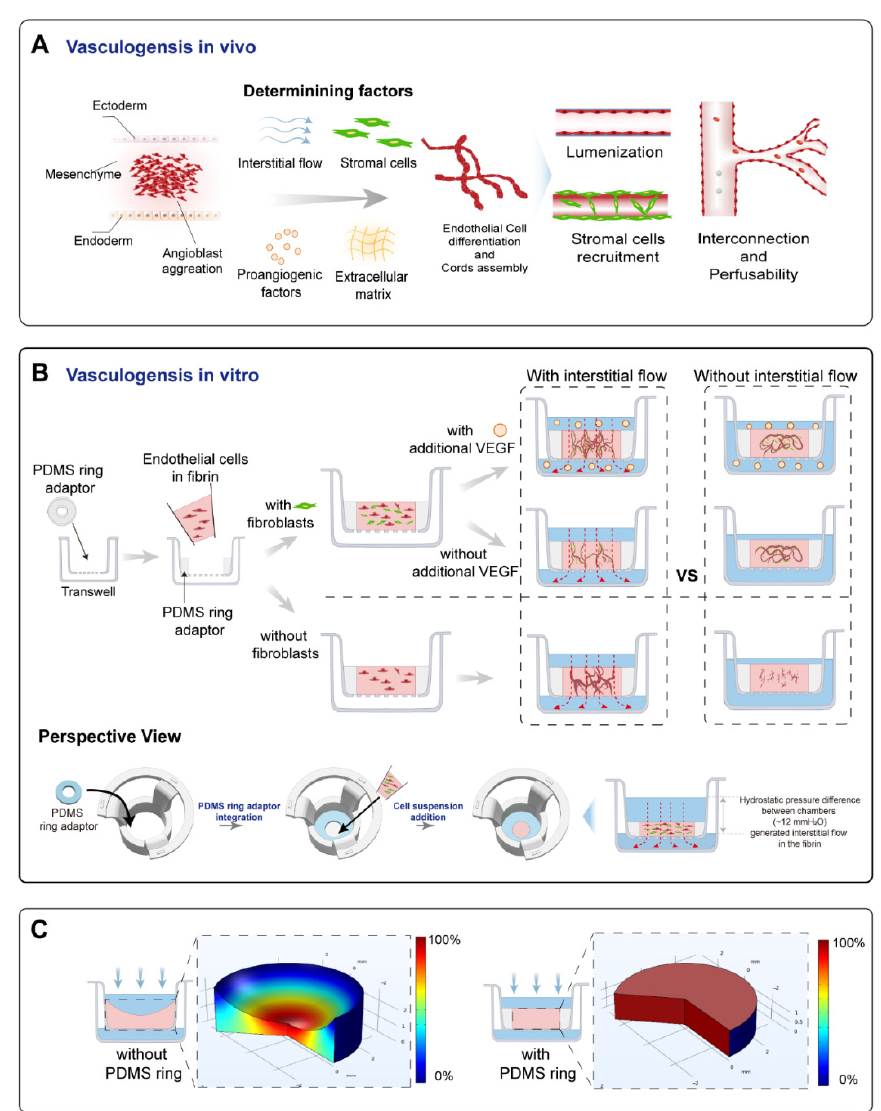
Figure 1. A schematic of the principle and the vascularized model design. ( A ) A schematic of the vasculogenesis in vivo. Vasculogenesis starts from angioblast aggregation and is orchestrated by various factors, including interstitial flow, stromal cells, pro-angiogenic factors, and the extracellular matrix. These determining factors were the focus of this study. Angioblast aggregation gradu- ally develops into assembled cords, then forms lumens, and further becomes interconnected and perfusable. Stromal cells are recruited to form the basement membrane and stabilize the vessels. ( B ) The operational process of this study. A PDMS ring adaptor was glued onto the membrane of the transwell using uncured PDMS. The endothelial cell suspension in fibrin mixed with/without fibroblasts was added into the central cavity of the PDMS ring. After fibrin solidification, a specific amount of medium with/without additional VEGF was added to the apical and basolateral chamber to achieve controllable hydrostatic pressure difference between chambers to apply an interstitial flow into the tissue. During 7 days of culture, interconnected vascular networks were formed. Addition- ally, comparisons between the fluidic and static groups were analyzed. ( C ) The simulated relative flow velocity distribution in the acellular fibrin with/without concaved meniscus. The velocity was normalized to the maximum velocity in the fibrin to obtain relative velocity distribution, and the rainbow bar indicated the relative velocity range from 0% (blue) to 100%